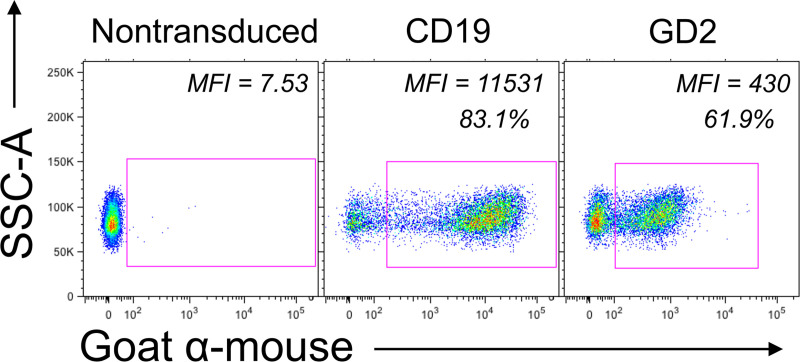
Transduction efficiencies for CD19.CAR-T cells and GD2.CAR-T cells represented by Median Fluorescence Intensity (MFI).Cells were stained with 233-4A (CD19 CAR target) and 1A7 (GD2 CAR target) anti-idiotype Abs followed by incubation with a goat-anti mouse secondary Ab. Control cells are represented by T cells (NT) following the same procedure of activation and expansion, but without the vector transduction.